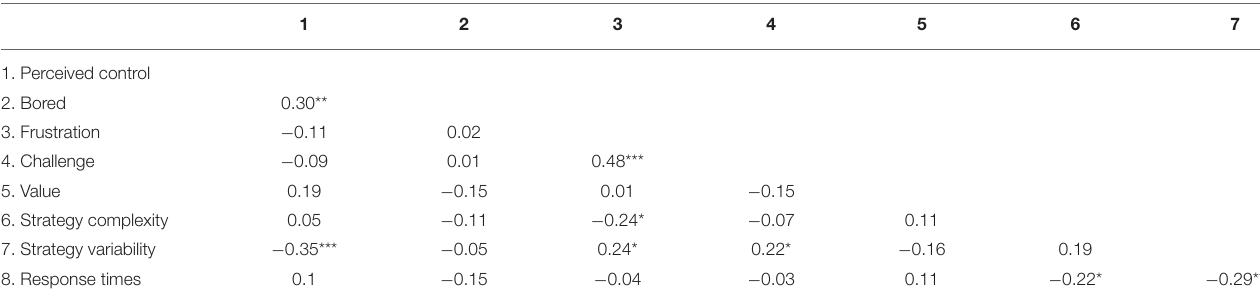
TABLE 2B | Zero-order correlations of all study variables in the High Perceived Control condition and their significance levels. 1